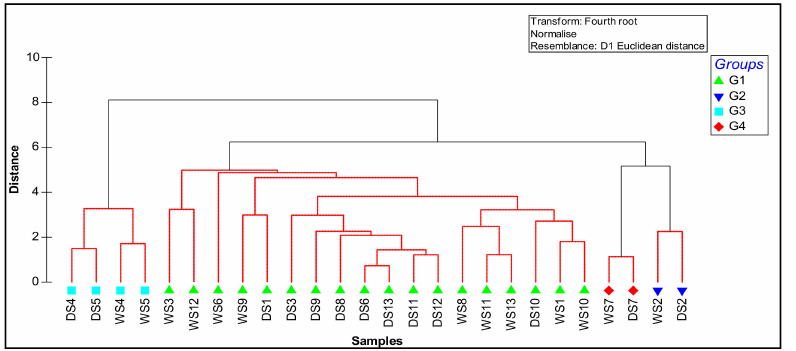
Figure 2. Dendrogram showing the cluster pattern during wet and dry seasons (WS, wet station and DS, dry station) of the geochemical parameters, granulometry, and TOC, on the basis of